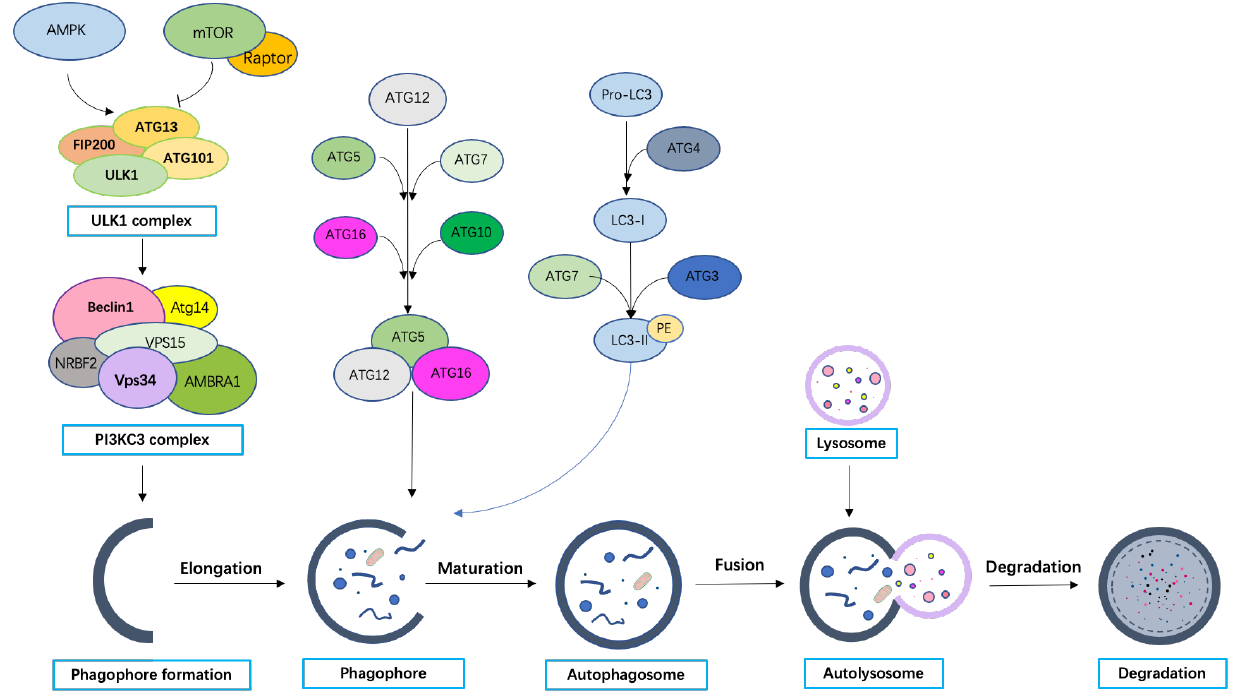
Figure 1. Molecular mechanisms of autophagy in mammalian cells.